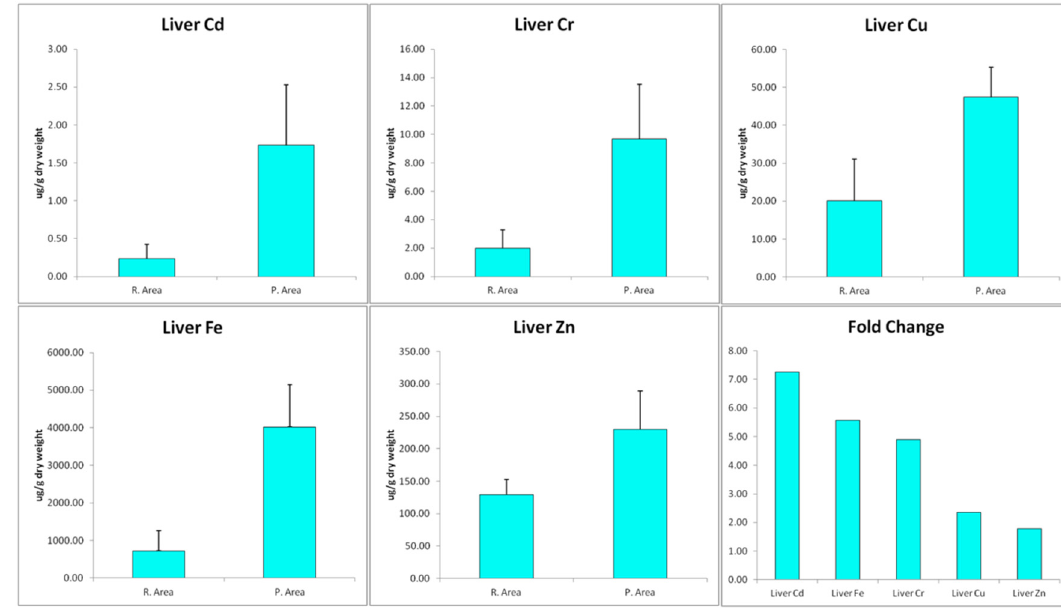
Figure 1. Concentrations of Cd, Cr, Cu, Fe and Zn in hepatic tissues (µg/g) of Variola louti .